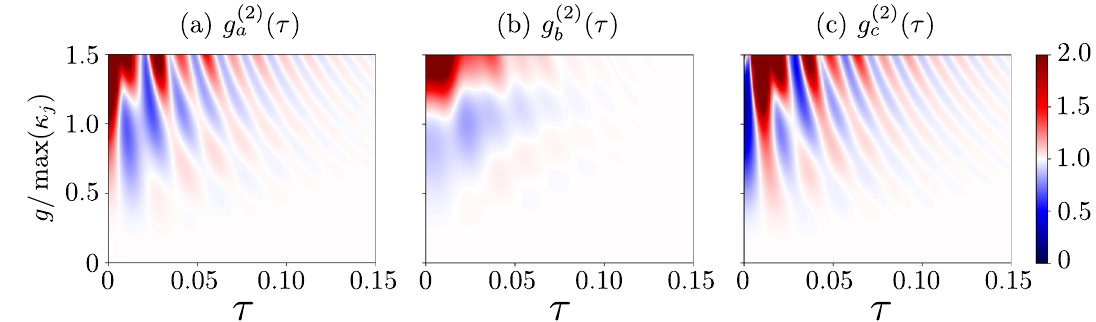
( 2 ) ( 2 ) (τ) for a (τ) for the photonic mode, ( b ) g b 2 are truncated ≥